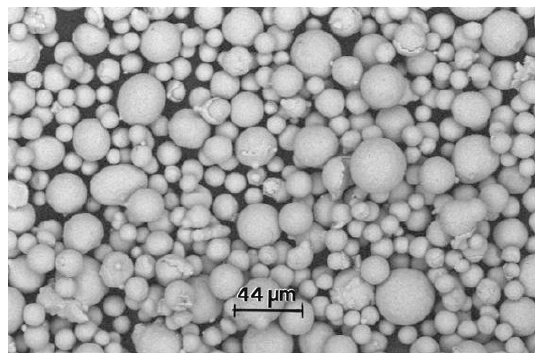
Figure 1. SEM micro-graph of the IN718 powder.